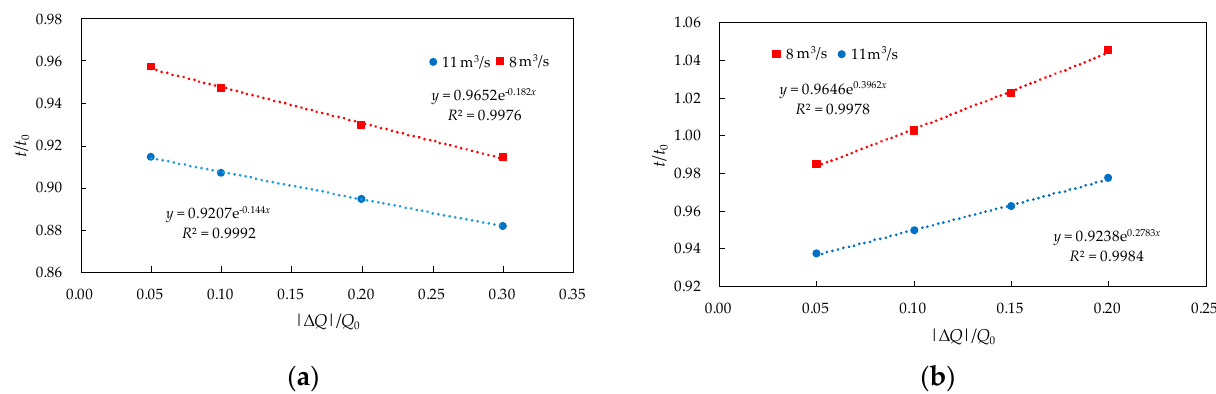
Figure 8. Relationship between | ∆ Q |/ Q 0 and t / t 0 for increasing ( a ) and decreasing discharge ( b ).